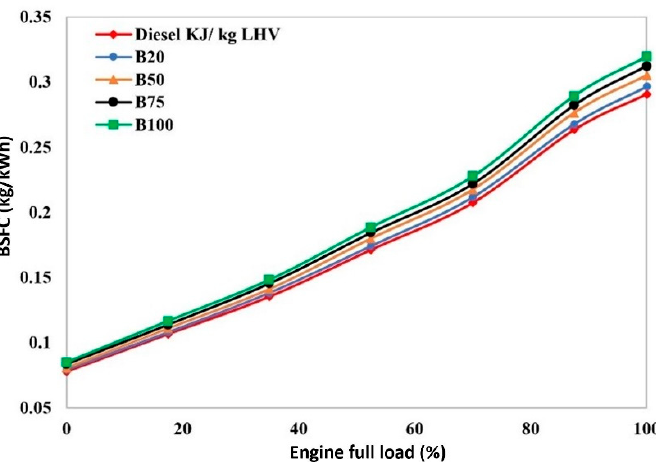
Figure 14. BSFC against load for diesel, sheep fat biodiesel (B100) and biodiesel blends (B20, B50 and B75)